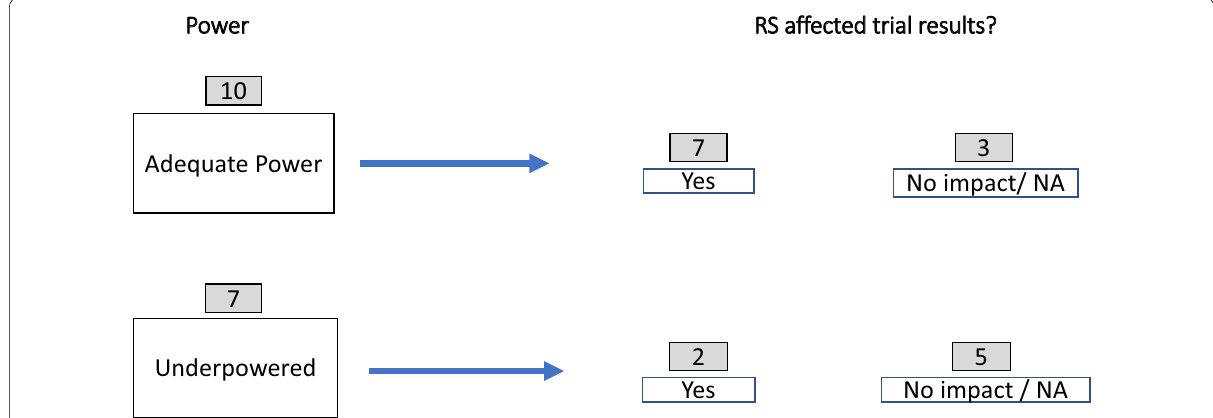
Fig. 3 Impact of power on response‑shift effects on trial results